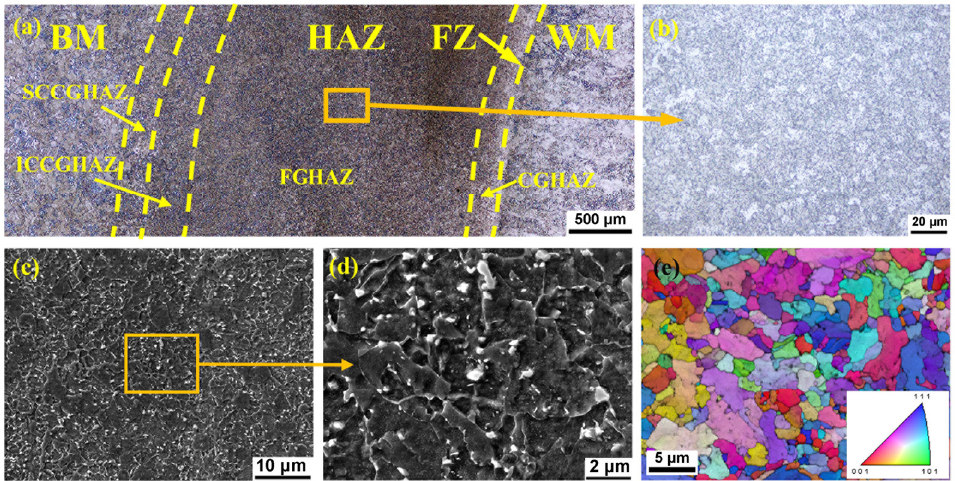
Figure 4. Microstructure of the turbine part HAZ: ( a ) the entire microstructure of the HAZ; ( b – d ) the microstructure of FGHAZ; ( e ) the inverse pole figure of EBSD in the FGHAZ.